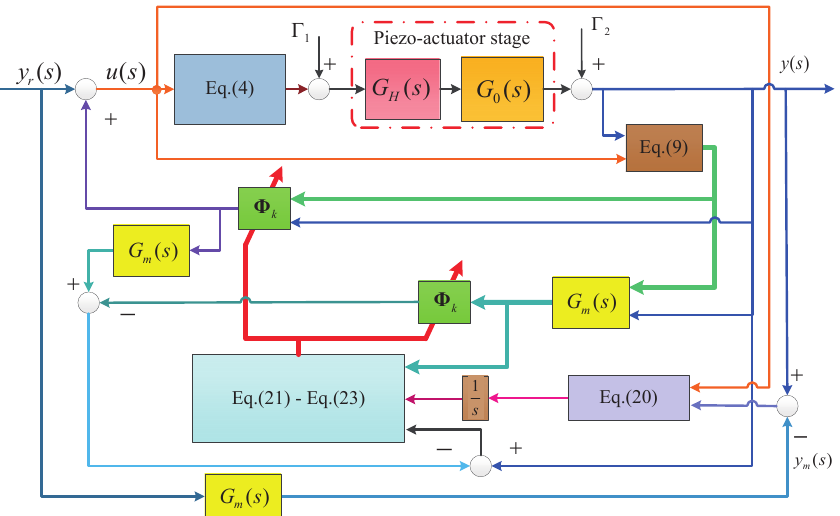
Figure 2. Structure of the proposed hybrid adaptive